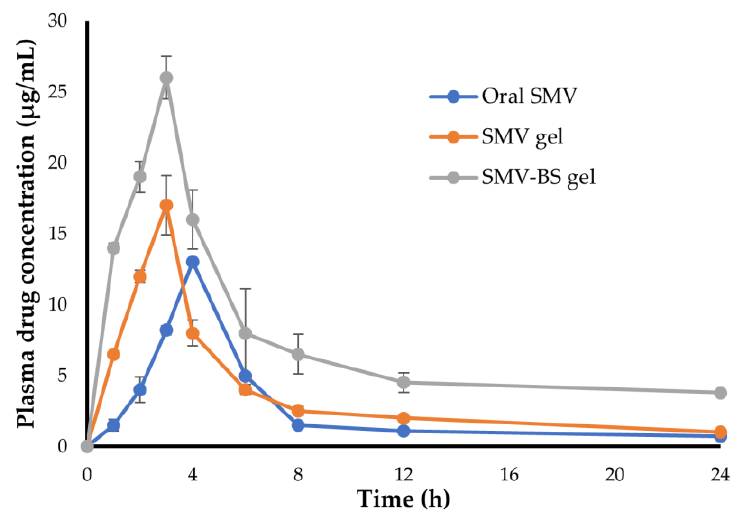
Figure 8. Plasma concentration vs. time curve of oral SMV suspension, topically applied palin SMV gel and topically applied SMV-BS gel. Data represent mean ± SD.